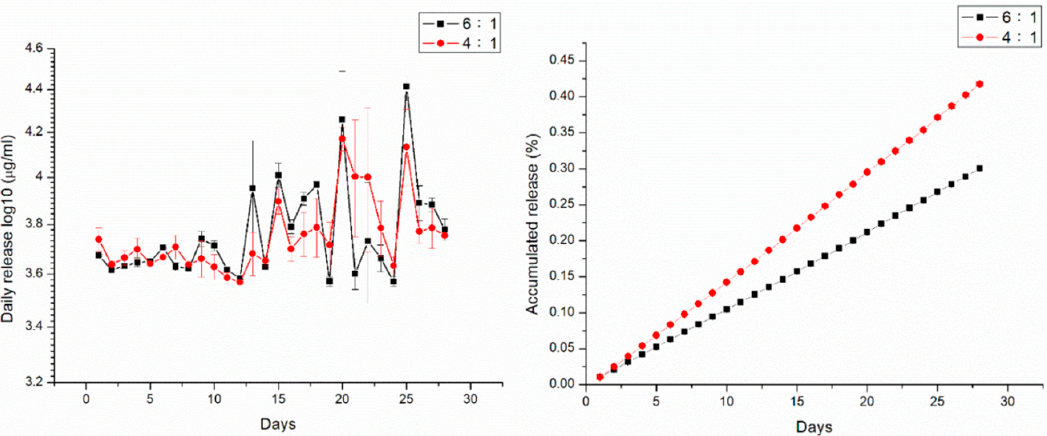
Figure 7. In vitro release curves of amphotericin B from the drug-loaded beads.